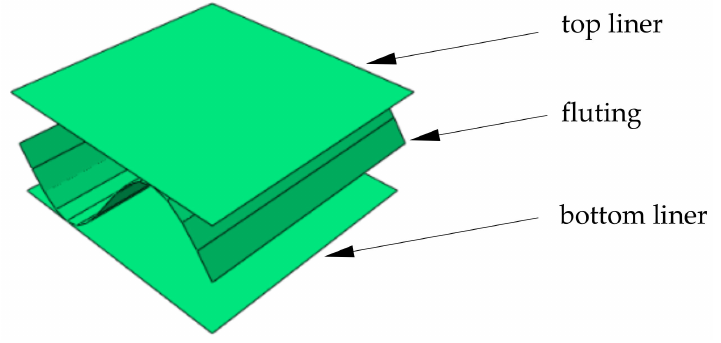
Figure 2. Representative volume element (RVE).